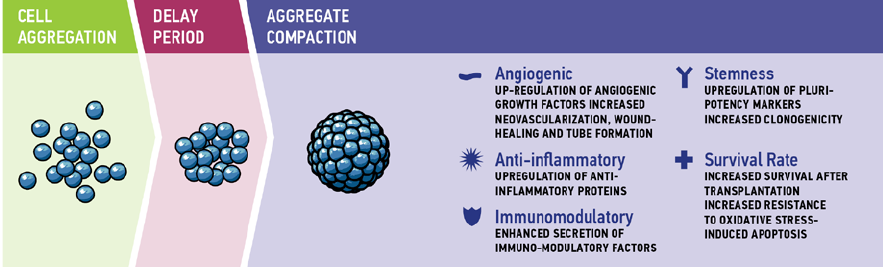
Figure 1. Three-step aggregation process: during the first phase of cell aggregation, cadherin–cadherin interactions and integrin binding to extracellular matrix proteins mediate the first cell–cell contacts. After a delay period of reorganization, aggregate compaction is mediated by cadherins.